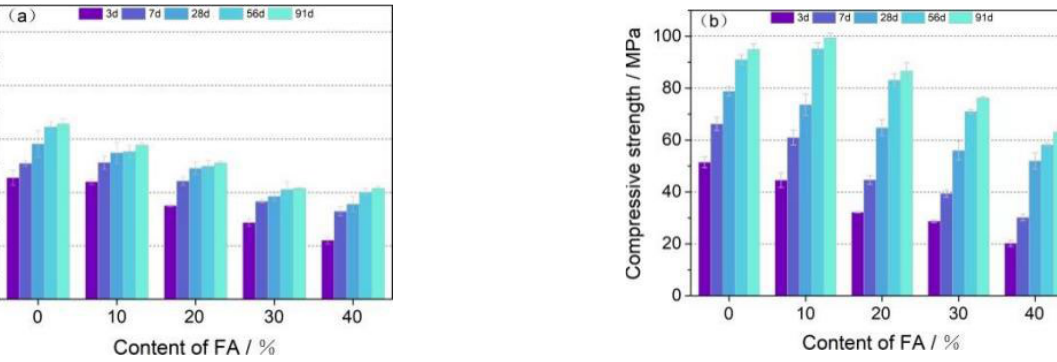
Figure 8. Compressive strength of OPC-FA samples. ( a ) Dry. ( b ) Water.